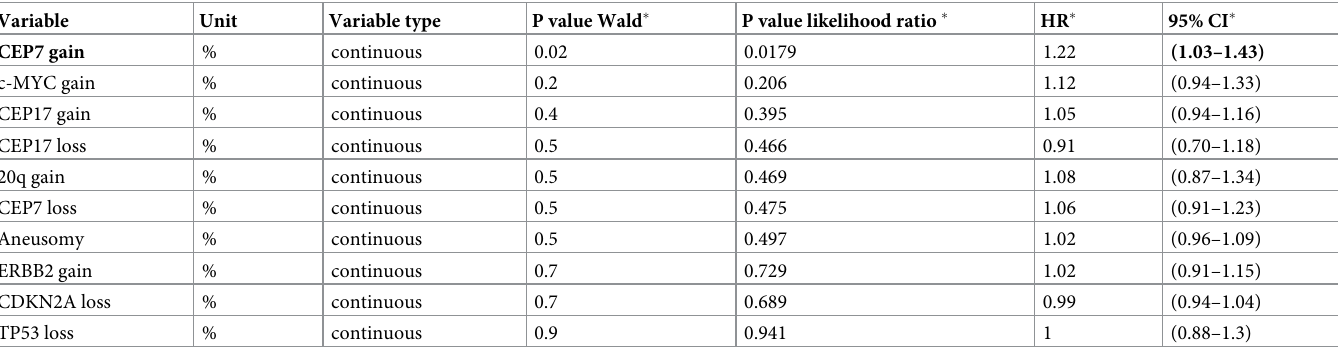
compared using multivariate regression analyses (Fig 1). In these models we included different combinations of the clinical, diversity and individual covariates that were found to be signifi- cant in the univariate analyses. Given the number of events, a maximum of 3 variables were included in each model to prevent overfitting. tion Criterion of 143 (IQR 121–166) and a median integrated Area Under the Curve of 0.76 (IQR 0.72–0.80). We found that the best performing model included a normalized clone score Table 5. Outcomes from univariate regression analysis of the genomic